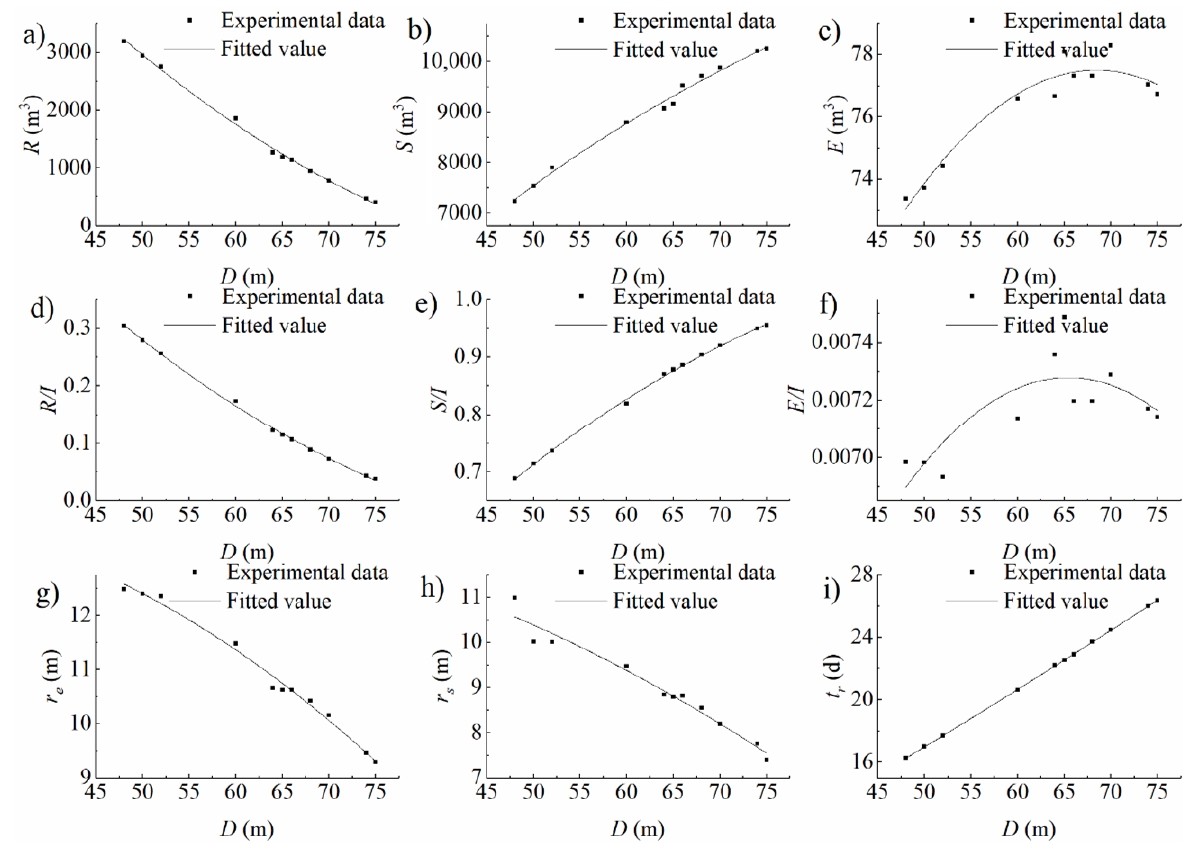
Figure 6. The variations with an increment in D . (( a ) variation of R; ( b ) variation of S; ( c ) variation of E; ( d ) variation of R/I; ( e ) variation of S/I; ( f ) variation of E/I; ( g ) variation of r e ; ( h ) variation of r s ; ( i ) variation of t r .).